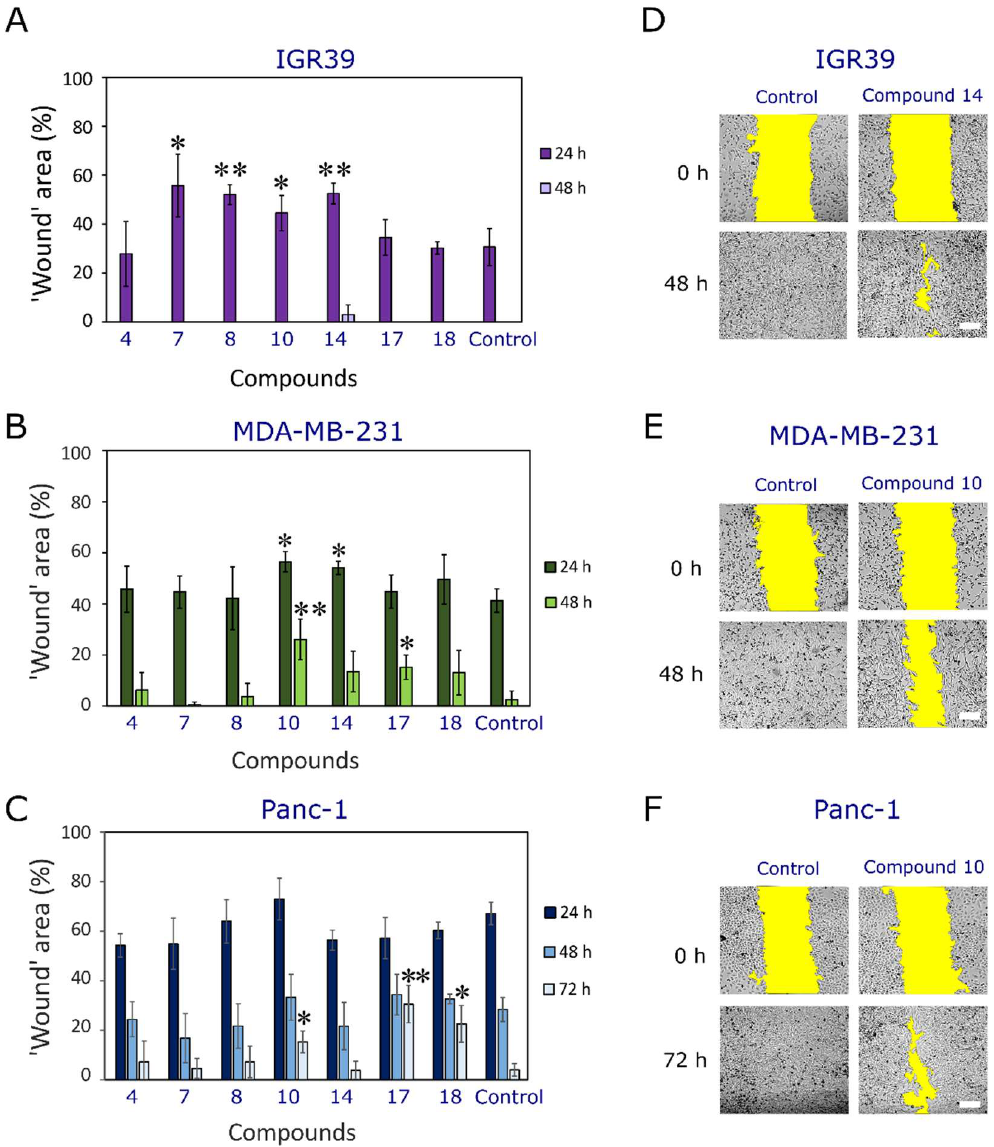
Figure 3. Effect of hydrazones 4 , 7 , 8 , 10 , 14 , 17 , and 18 on human malignant melanoma IGR39 ( A ), human triple-negative breast cancer MDA-MB-231 ( B ), and human pancreatic carcinoma (Panc-1) ( C ) cell migration; n = 3. Photos of the ‘wound’ area (marked in yellow) in IGR39 ( D ), MDA-MB-231 ( E ), and Panc-1 ( F ) monolayers at the beginning and the end of the experiment. Scale bar indicates 100 µm. The asterisks (*) indicate p < 0.05 and (**) indicate p < 0.01 compared to the control (untreated cells).